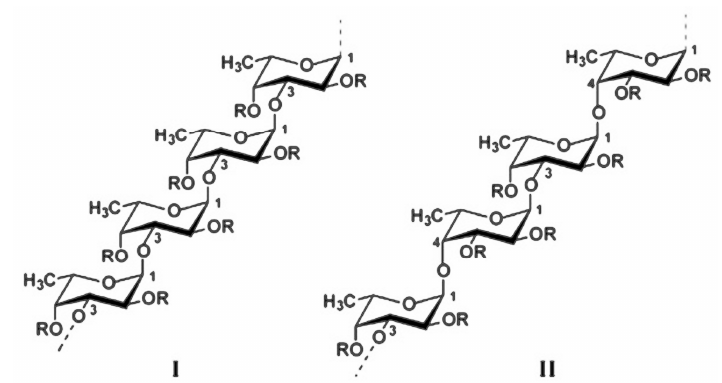
Figure 2. Fucoidans with α -(1 → 3) linked l -fucose residues ( I ) or alternating α -(1 → 3) and α -(1 → 4) linked l -fucoses ( II ). R represents the possible attachments of carbohydrate and noncarbohydrate substituents (sulfate and acetyl groups) [22].